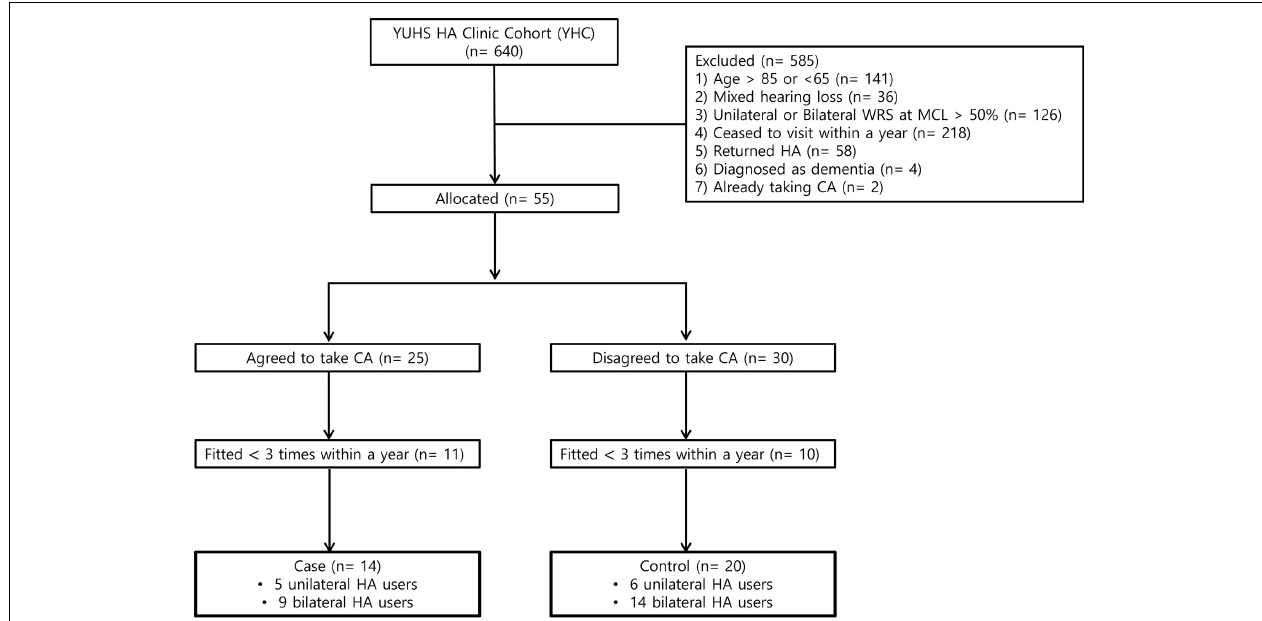
FIGURE 1 | Flow chart of the case-control study for evaluating the effect of oral choline alfoscerate on speech detection and recognition in hearing aid users with aging-related hearing